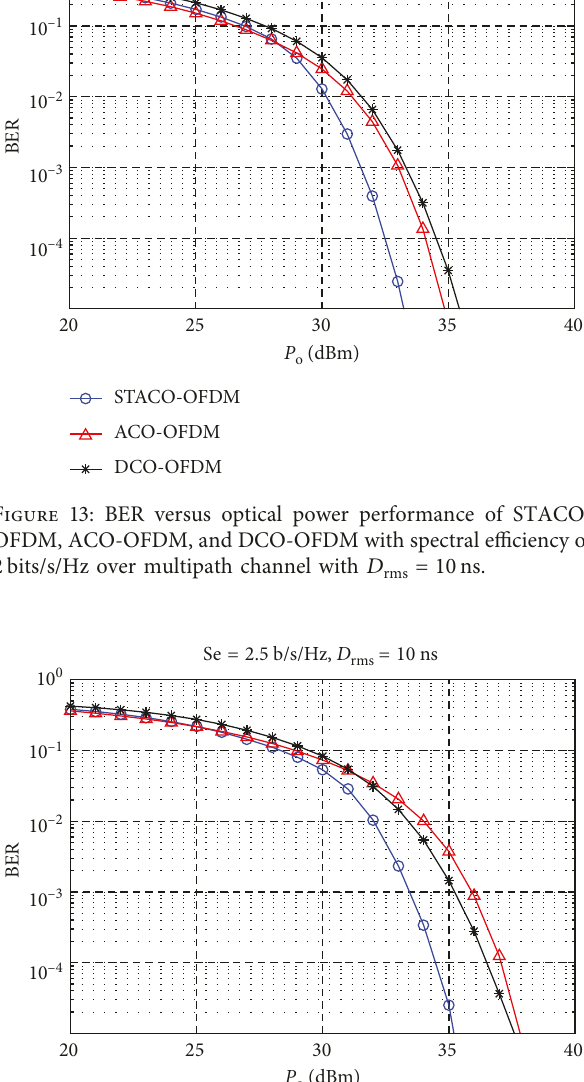
Figure 14: BER versus optical power performance of STACO- OFDM, ACO-OFDM, and DCO-OFDM with spectral efficiency of 2.5bits/s/Hz over multipath channel with D rms